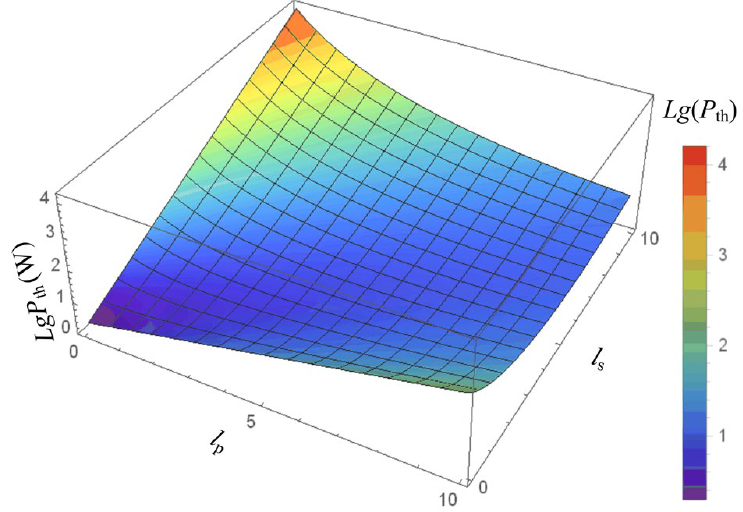
Figure 4. Threshold of the SPP-SRO for different combinations of pump vortex order l p and resonant signal vortex order l s in logarithmic coordinate.